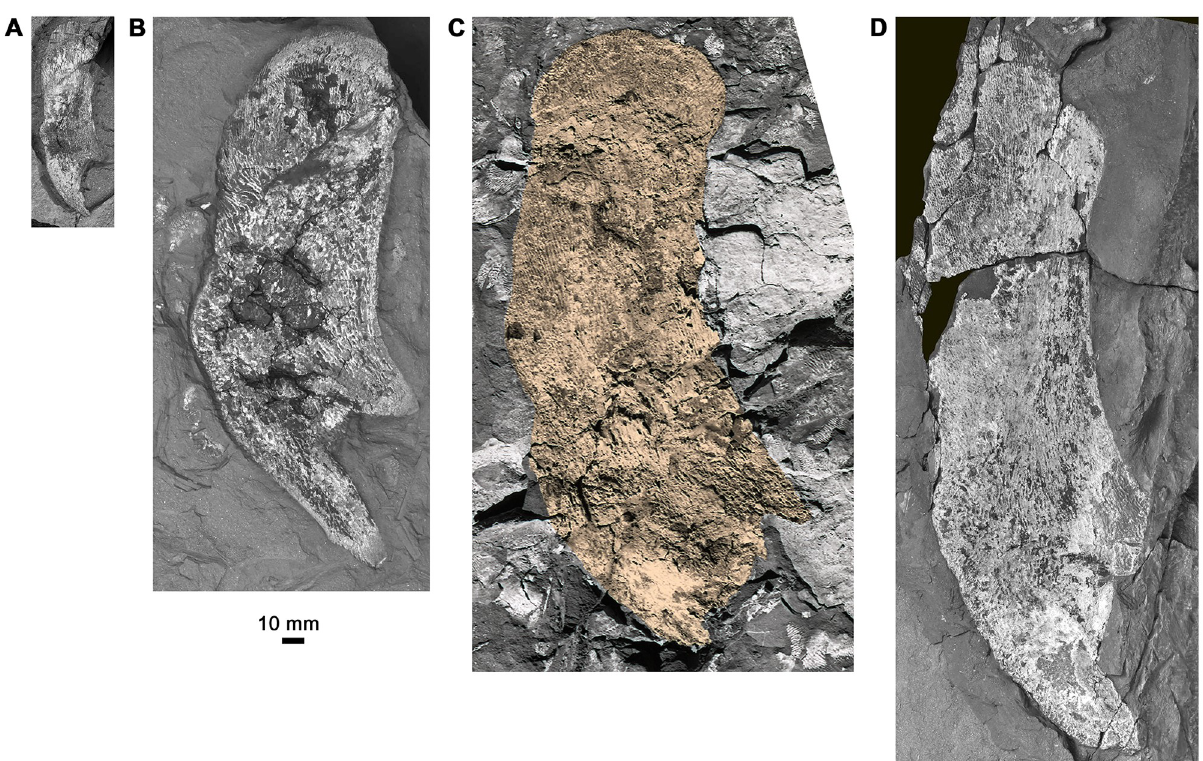
Fig 10. Variability of the cleithrum. A, cleithrum 6516a,b (composite image of part and counterpart). B, cleithrum AM6540b. C, cleithrum AM5389a, highlighted in gold to facilitate visualisation. D, cleithrum AM6545. All to same scale.